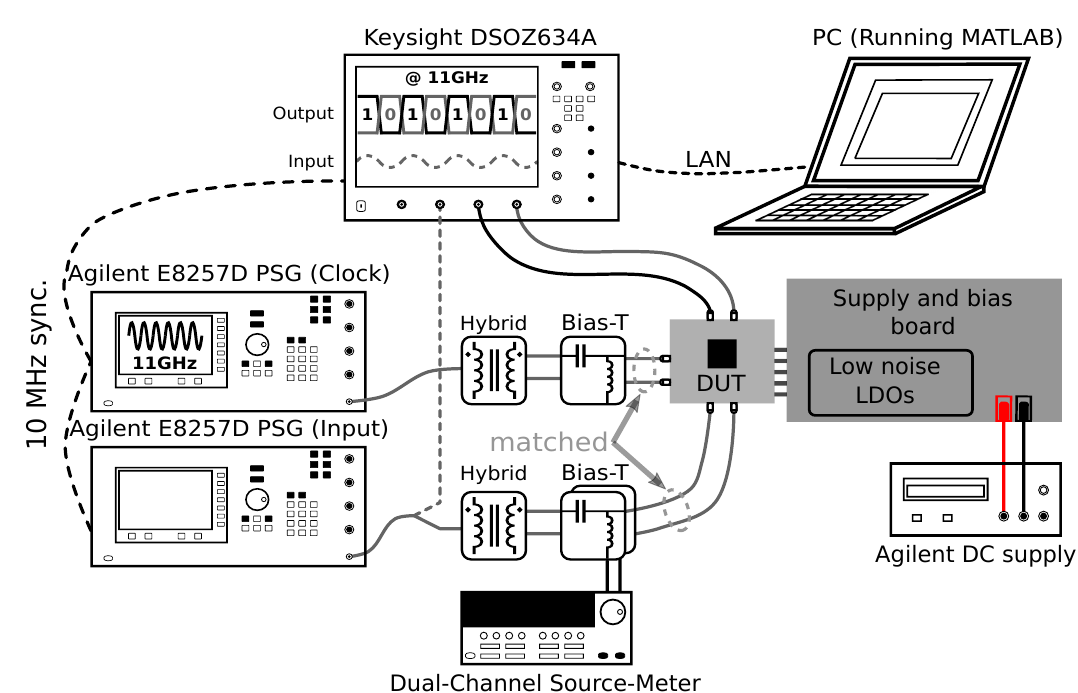
Figure 7. Measurement setup of the proposed self-calibrating comparator. LDO, Low-Dropout